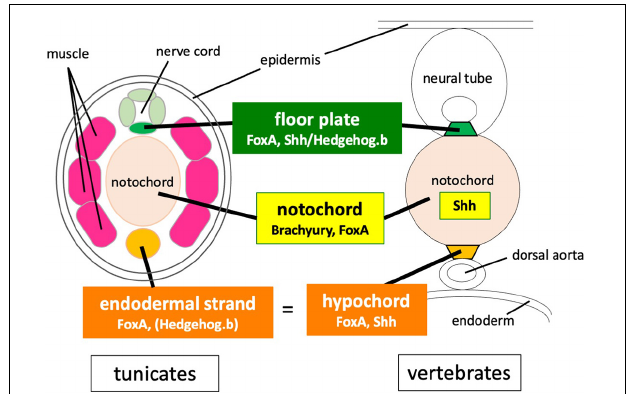
FIGURE 6 | Comparison of developmental programs for midline tissues between tunicates and vertebrates. Co-expression of Brachyury and FoxA family transcription factors is required for notochord development both in vertebrates and tunicates. Both the notochord and the floor plate secrete Shh in vertebrate embryos, whereas hedgehog genes are not expressed in the notochord of tunicate embryos. FoxA and Shh / hedgehog.b are co-expressed in the floor plate of both vertebrates and tunicates. FoxA and Shh are also co-expressed in the hypochord precursor. The tunicate endodermal strand expresses FoxA.a and has a latent transactivation potential of hedgehog.b